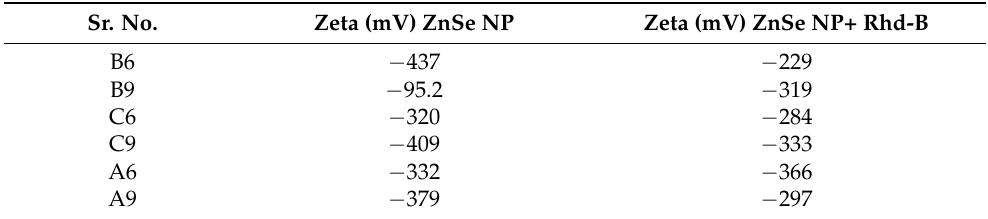
Table 1. Zeta potential values of ZnSe nanostructures before and after the addition of Rhd-B. Sr.